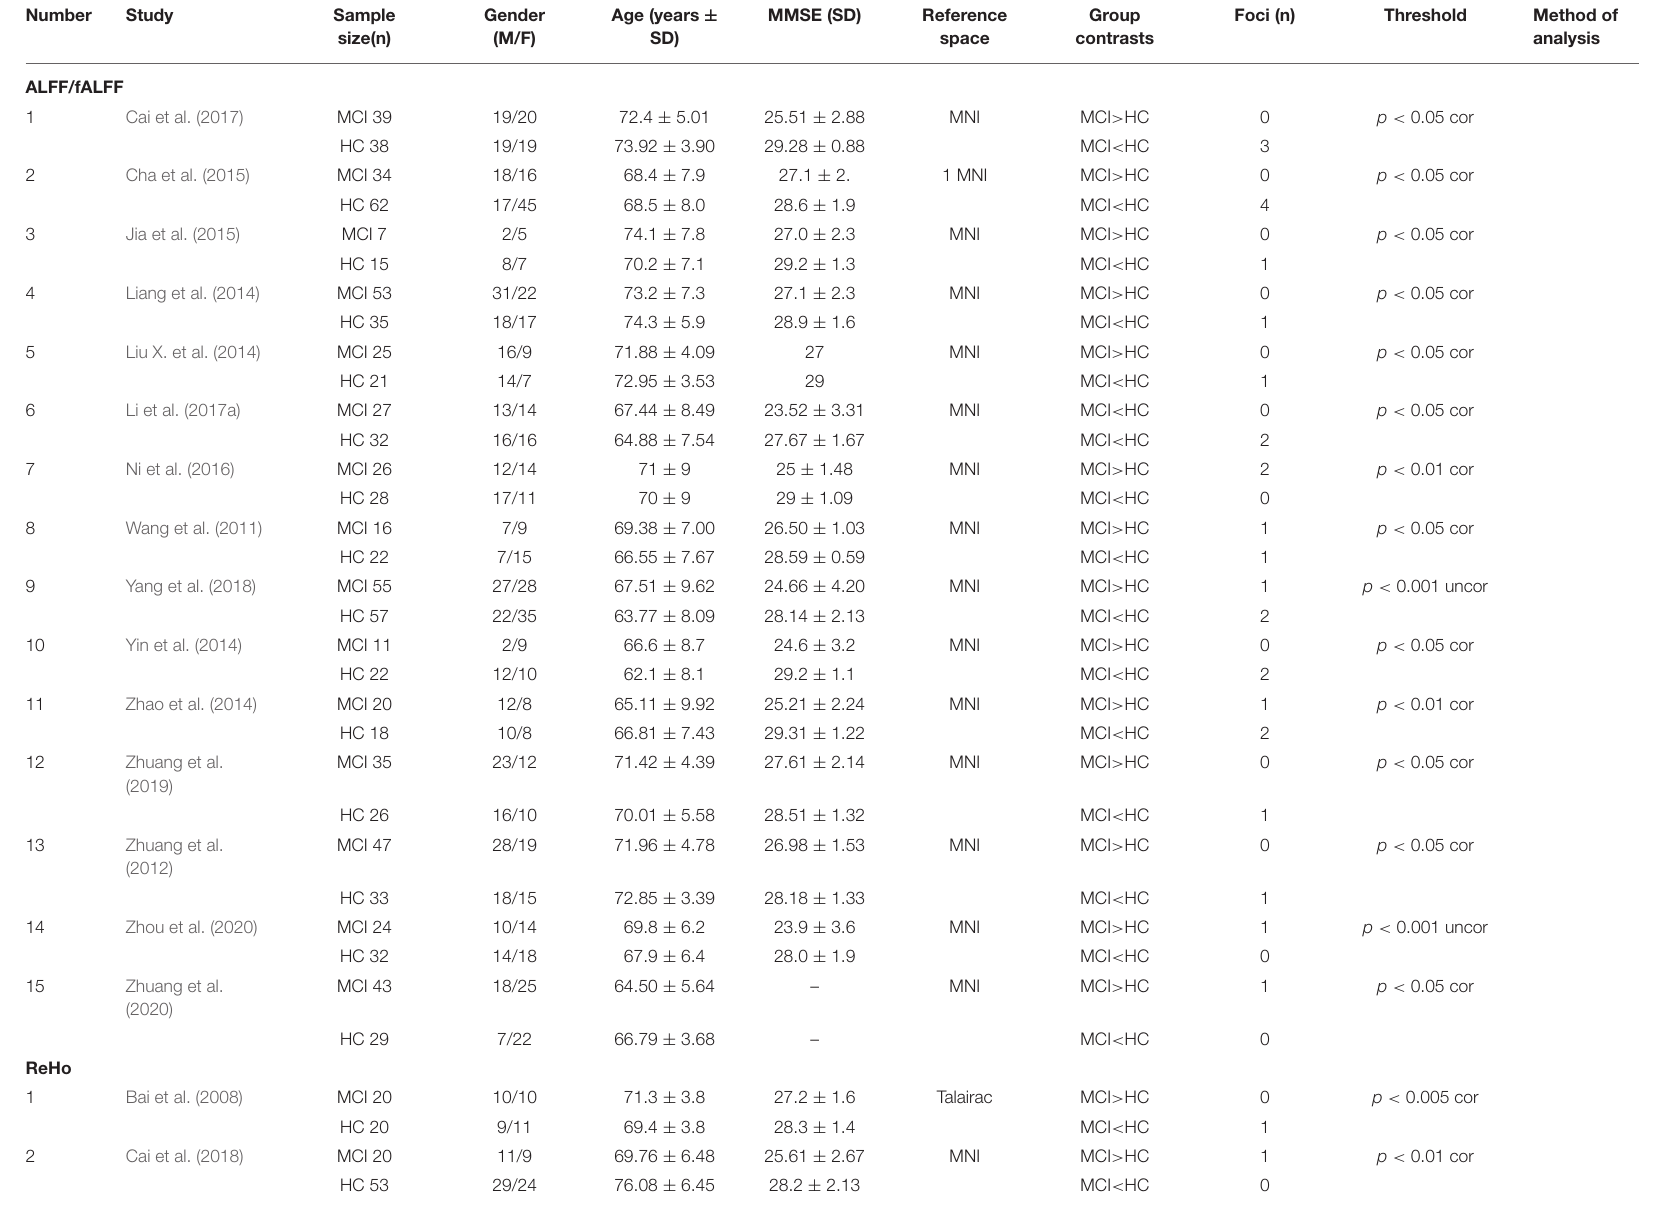
TABLE 1 | Demographic characteristics of the included rs-fMRI